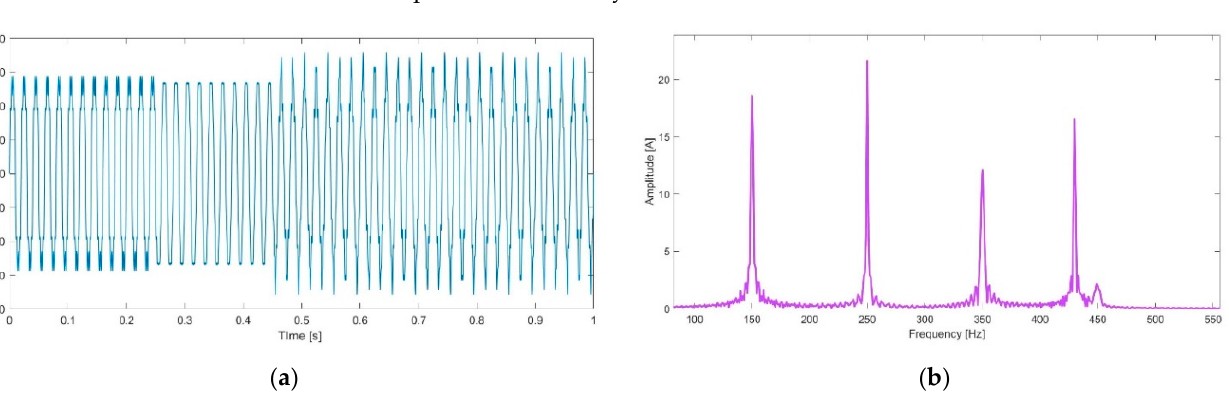
( b ) ( c ) Figure 4. ( a ) First quasi-steady-state interval enhanced with a Hanning window, ( b ) second interval enhanced with a Hanning window, ( c ) last interval enhanced with a Hanning window. With the objective of identifying and separate the modes of oscillation inside the orig- inal distorted signal, with the quasi-steady-state intervals computed, we can now apply DFT over each of these time intervals and calculate the instantaneous frequencies and the